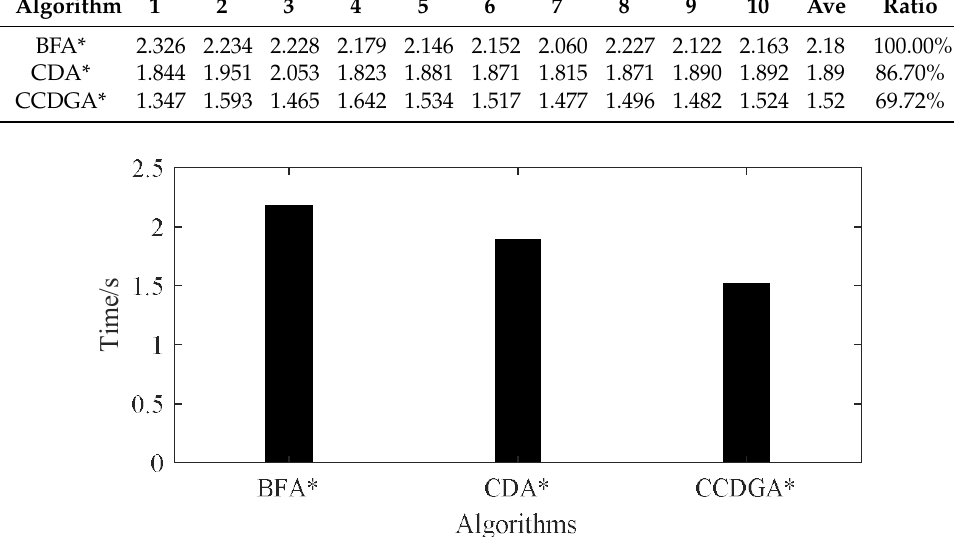
Figure 18. Average Diagnosis Time for BFA*, CDA* and CCDGA*. Table 8. Tried Candidates, Expanded Nodes and Nodes in Queue for Single Diagnosis.